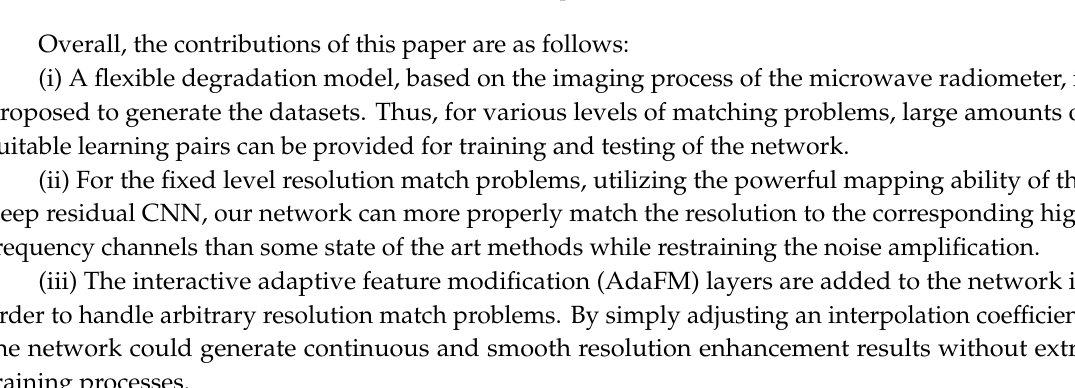
Figure 1. Illustration of the accommodative spatial resolution match (ASRM)